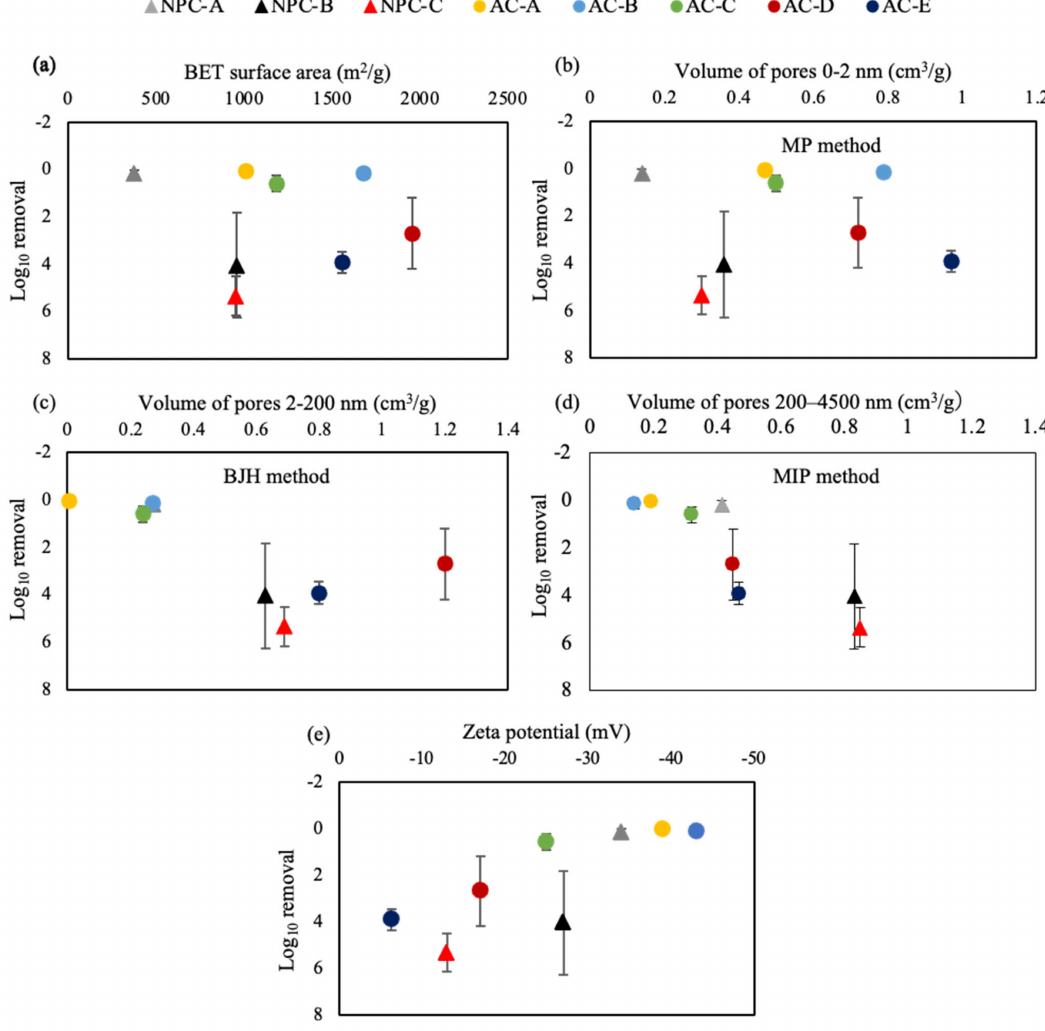
Figure 4. Relationship between MS2 removal and the BET surface area ( a ) and the volume of MP pores ranging from 0–2 nm ( b ), BJH pores ranging from 2–200 nm ( c ), MIP pores ranging from 200–4500 nm ( d ), and zeta potential ( e ) for NPCs and ACs at the contact time of 60 min. Error bars indicate the standard deviation (n =